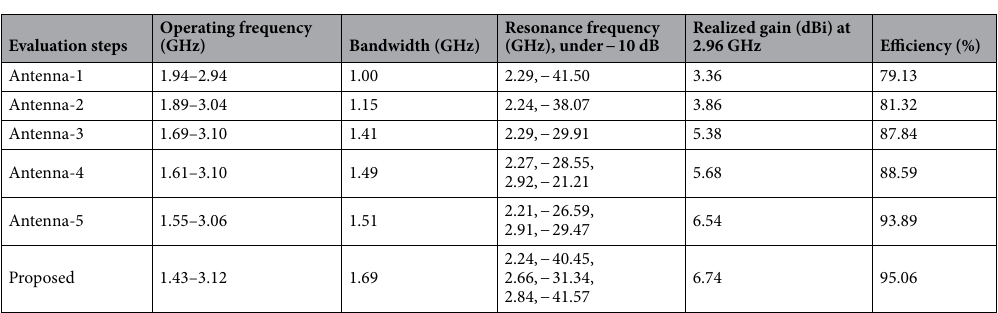
Table 2. Overall 3D stacked antenna